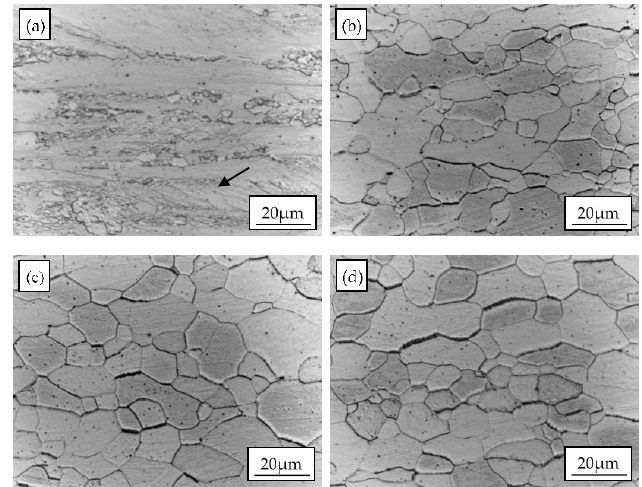
Figure 2. Optical micrographs of experimental steel batch annealed at different temperatures ( a ) 580 ◦ C; ( b ) 630 ◦ C; ( c ) 680 ◦ C; ( d ) 730 ◦